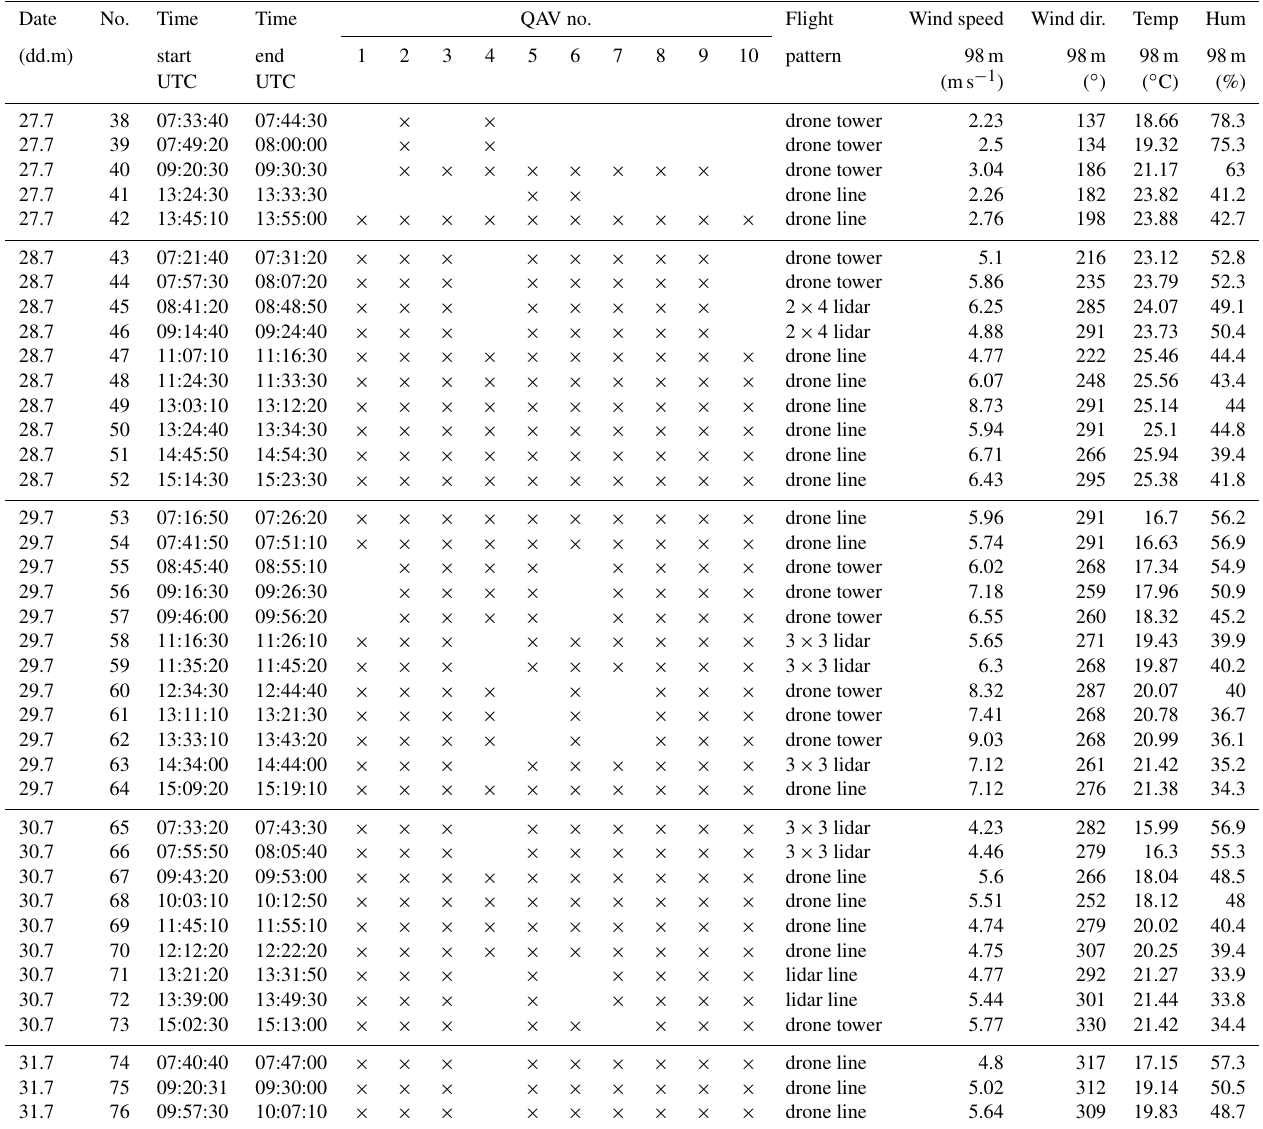
Table E2. Flight protocol of the second week of the FESST@MOL